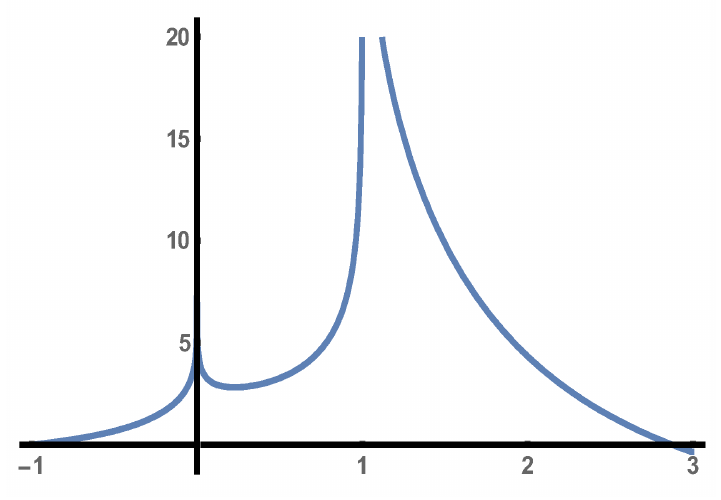
Figure 1. Graph of the real part of the solution (2).